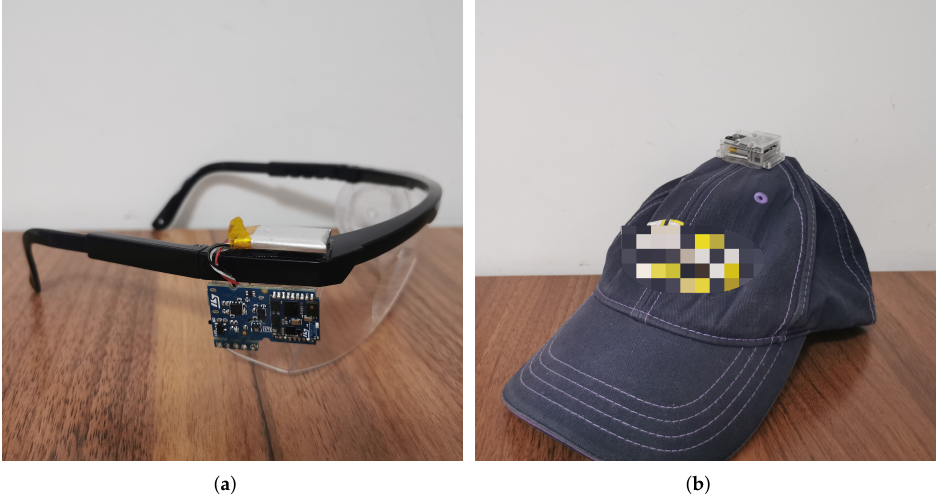
Figure 2. Placement of sensor modules ( a ) on the glasses ( b ) on the cap.